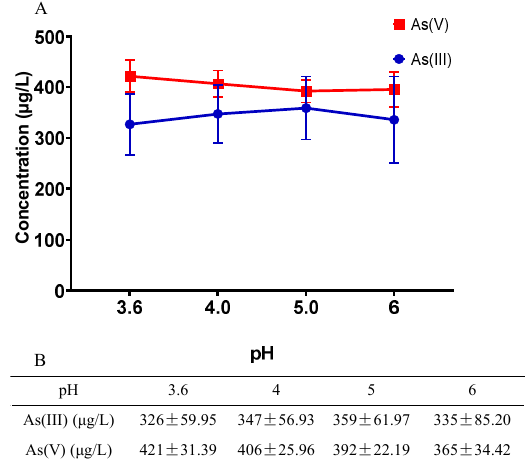
Figure 5. Changes of As species corresponding to different pH. ( A ) As(III) and As(V) trends, ( B ) As(III) and As(V) contents.